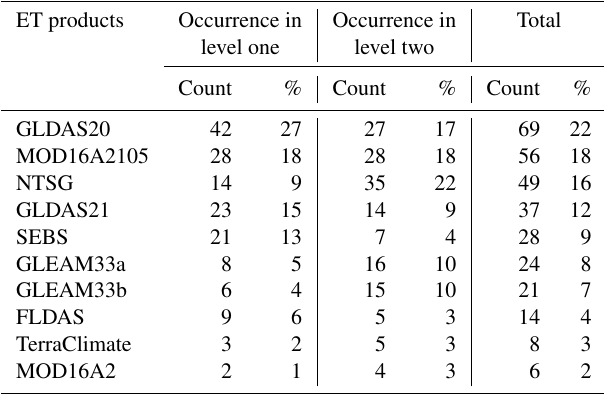
Table 8. The occurrence of all ET products except PML and SSE- Bop products.